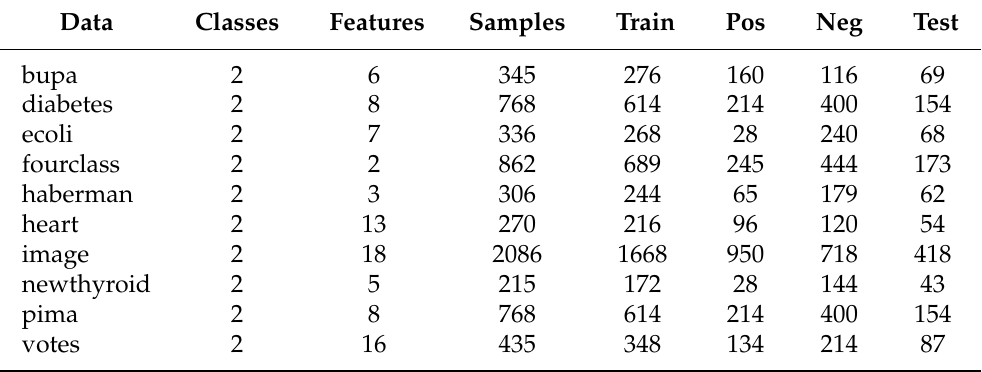
Table 1. Information of the binary data